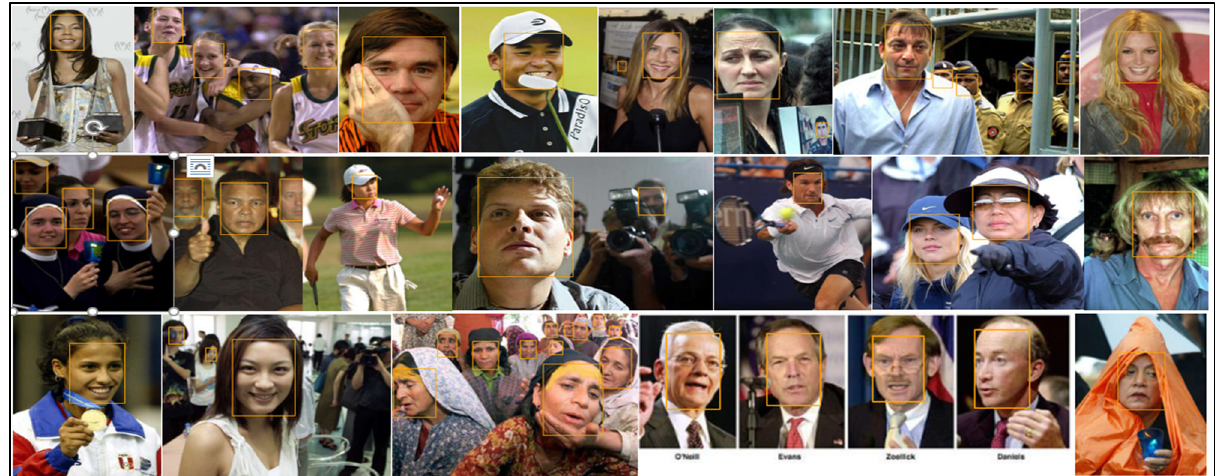
Figure 2. The detection results the FDDB dataset.